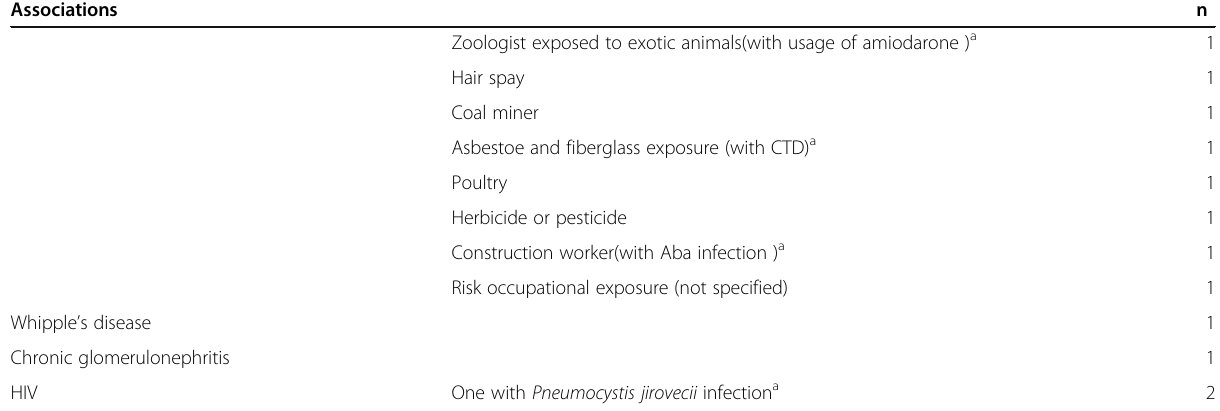
Table.2 Possible causes or associations with AFOP (Continued)